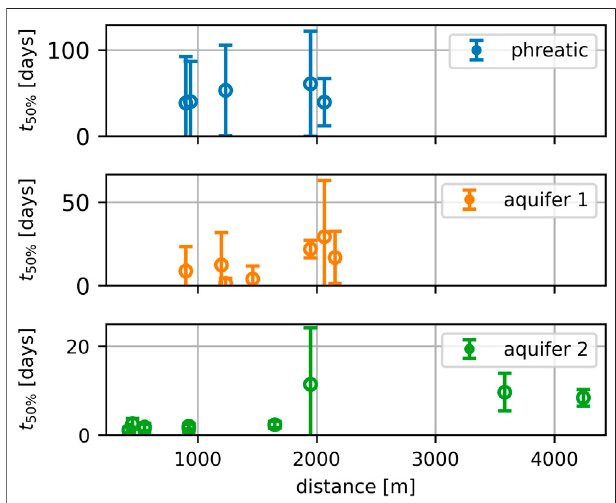
FIGURE 8 | Estimated 50% response time for observations wells near well fi eld Hemmen including estimated uncertainty (2 σ